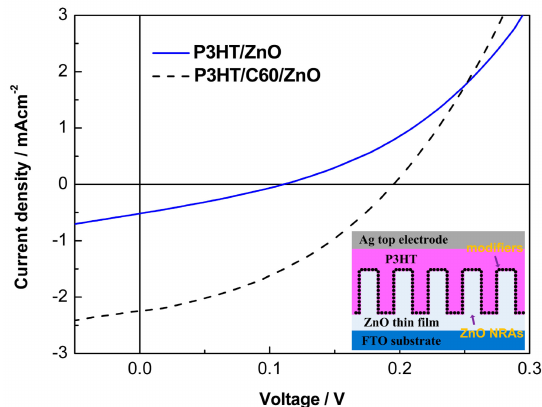
Figure 5. J-V curves of the hybrid solar cells based on P3HT/ZnO NRAs, the inset shows the device structure.